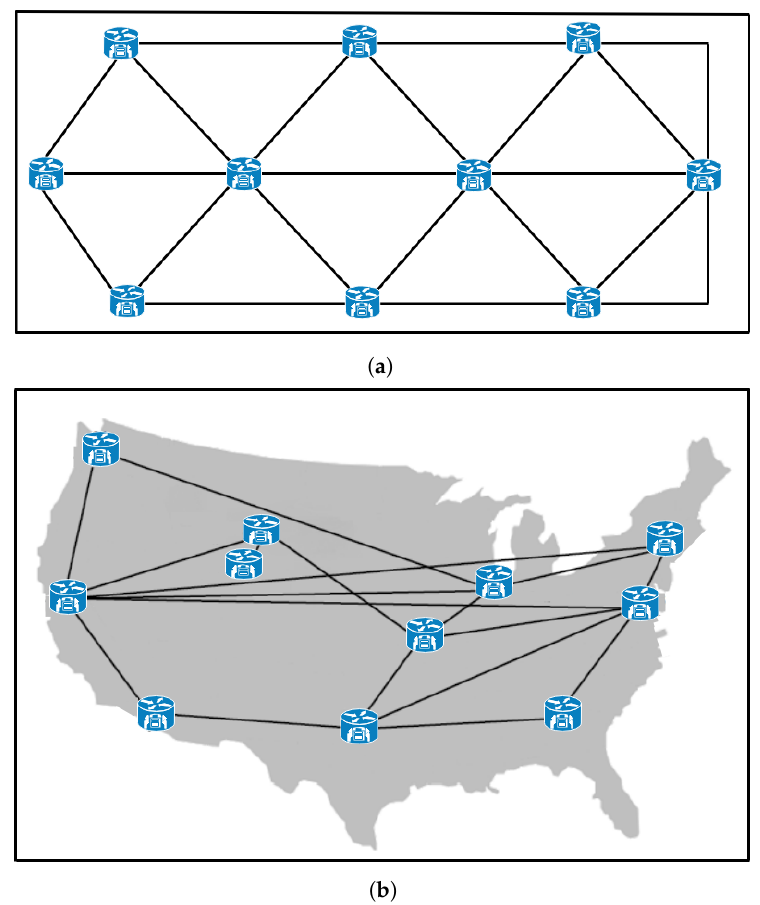
Figure 8. Network topologies adopted in this paper. ( a ) The depiction of the industrial network topology. ( b ) The depiction of the sprint topology.